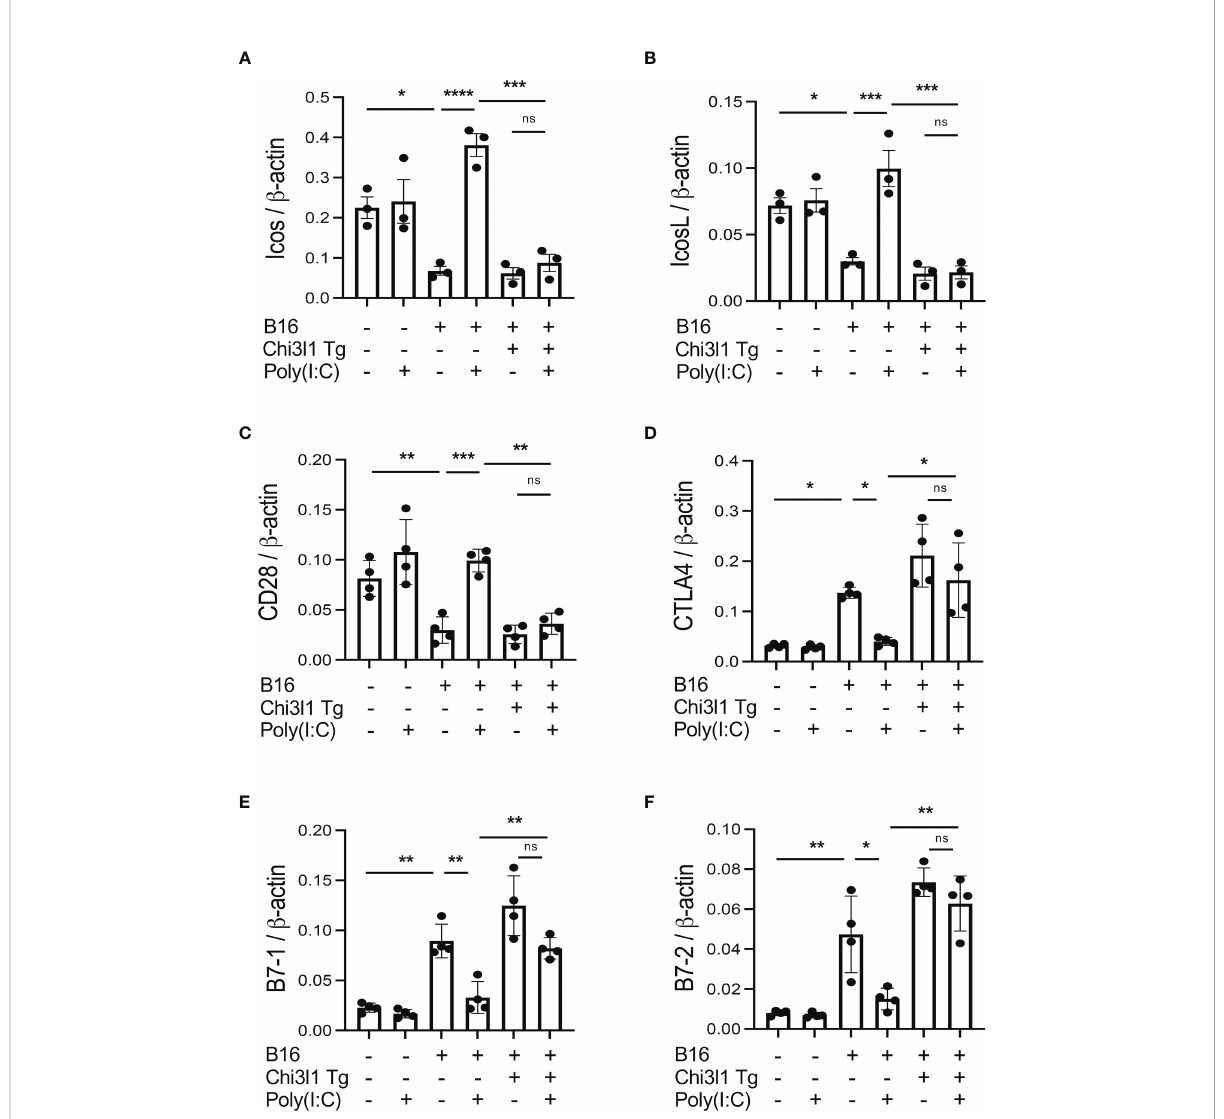
FIGURE 6 Effects of transgenic Chi3l1 on Rig-like helicase (RLH) inhibition of co-stimulation and induction of CTLA-4, B7-1 and B7-2. WT mice and Chi3l1 Tg+ mice were given B16-F10 (B16+) melanoma cells or PBS control (B16-) and treated with Poly(I:C) (Poly (I:C+) or its vehicle control (Poly(I: C-) and evaluated 2 weeks later. (A-F) RT-PCR was used to quantitate the levels of mRNA encoding ICOS, ICOSL, CD28, CTLA-4, B7-1 and B7-2 in lungs from WT mice and Chi3l1 Tg+ mice treated with Poly(I:C) (Poly (I:C+) or its vehicle control (Poly (I:C-) as noted. The plotted values in panels (A – F) represent the mean±SEM of the evaluations represented by the individual dots. * P < 0.05, ** P < 0.01, *** P < 0.001, **** P <0.0001. (ANOVA with multiple comparisons). ns, not signi fi